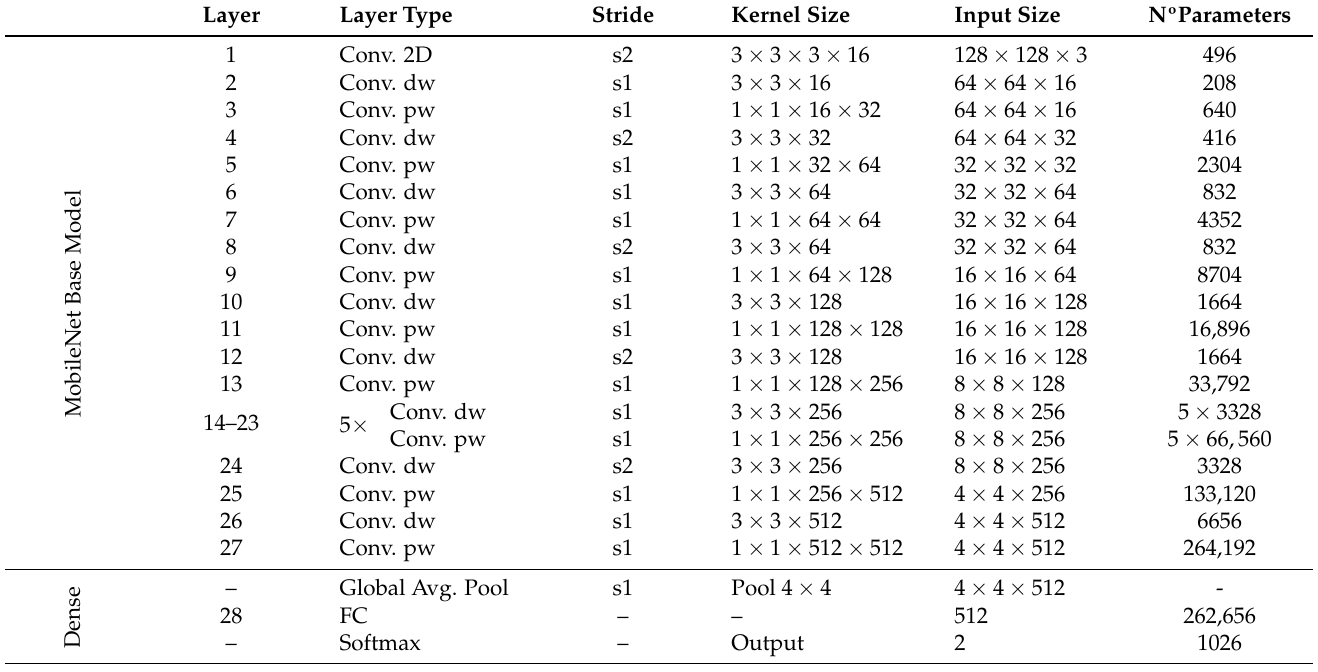
Figure 3. Depthwise separable convolution of the MobileNet, which factorizes the convolution into depthwise and pointwise convolutions. Table 2. Architecture of the MobileNet with transfer